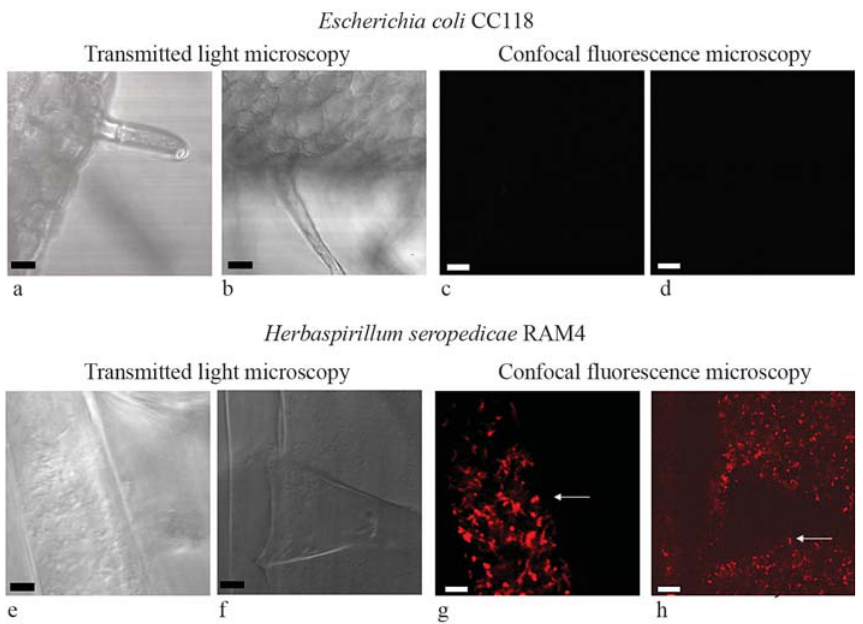
Figure 1 - Maize root tissue thirty minutes and one hour after inoculation with Herbaspirillum seropedicae strain RAM4 or E. coli CC118 (control), both expressing red fluorescent protein. Photomicrographs of a cross-section of maize root thirty minutes (a, c, e and g) and one hour (b, d, f and h) after inocu- lation with E. coli CC118 (upper panel) or H. seropedicae strain RAM4 (bottom panel). Left – transmitted light microscopy, righ – confocal fluorescence microscopy. Arrows show bacteria accumulating in the lateral root. After one hour clumps of bacteria can be seen at the lateral root junctions and spread- ing into the epidermis. Bars: a = 15 μ m; b = 50 μ